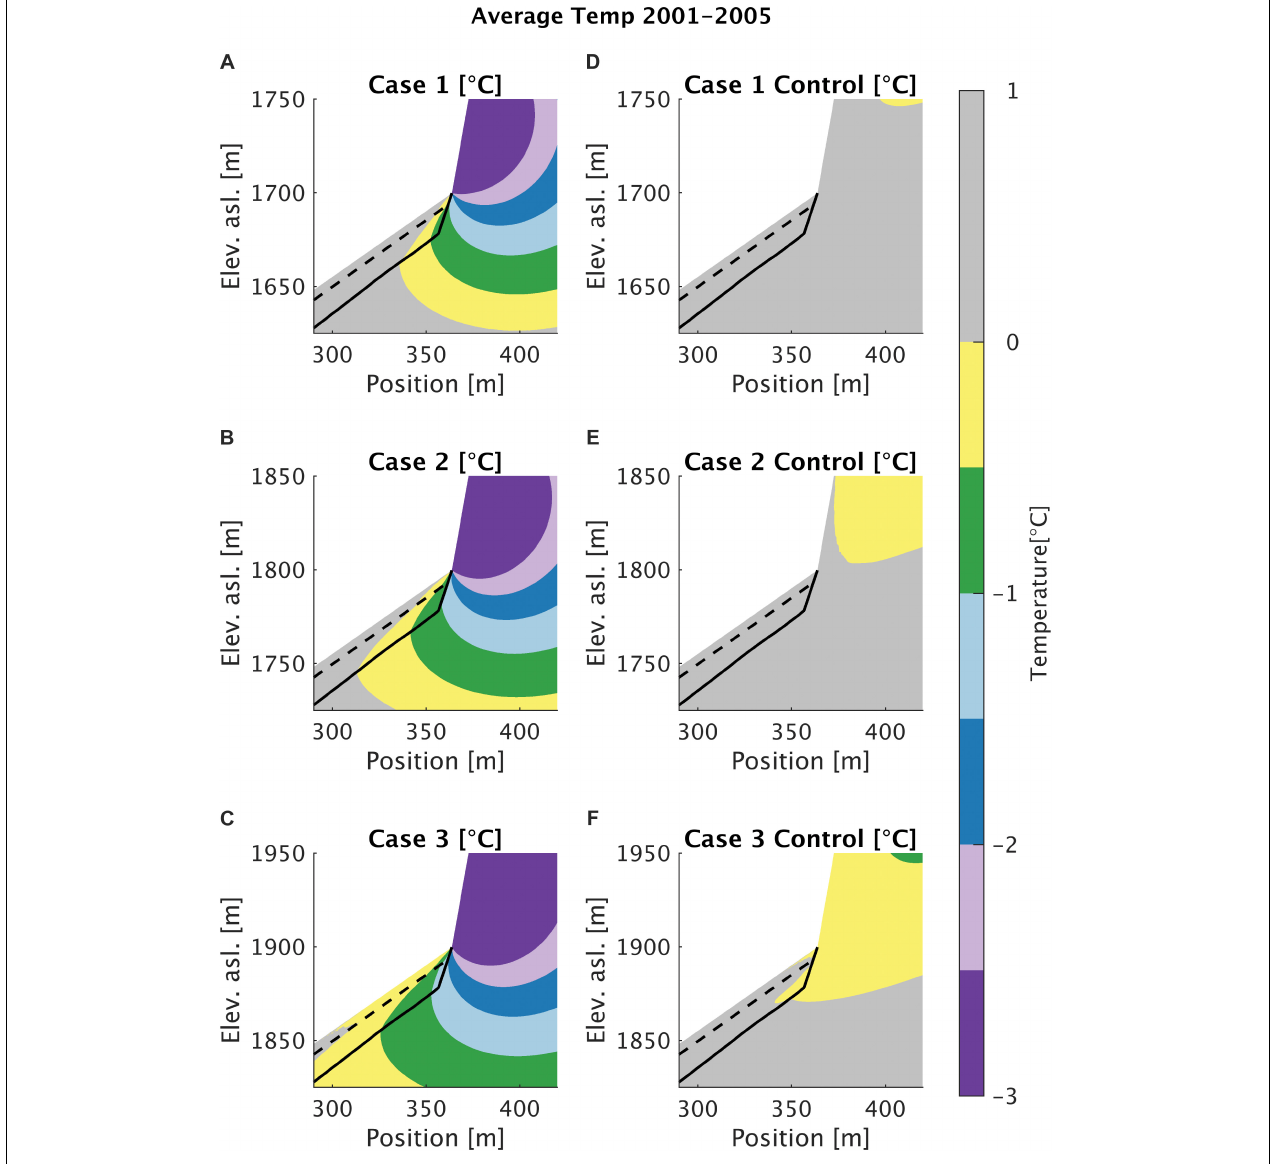
FIGURE 3 | Comparison of simulated average ground temperatures in the period 2001–2005 for the geometry situated at different elevations, Case 1–3 (A–C) and Case 1–3 Control (D–F) . The plotted areas are cut-outs from the numerical domain presented in Figure 1B . Colors indicate temperatures below 0 ◦ C. All simulations are run with mineral thermal heat conductivity k = 3.5 W/m ◦ C and geothermal heat flux 50 mW/m 2 . Snow covers are implemented along the talus slope for both simulations by means of nF = 0.2. For the control simulations, nF = 0.2 is implemented along the steep rock